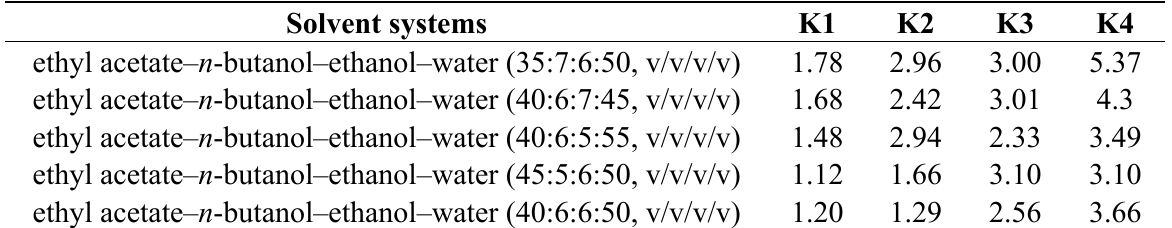
Table 1. K values of the compounds in different solvents system with different radios. Solvent systems